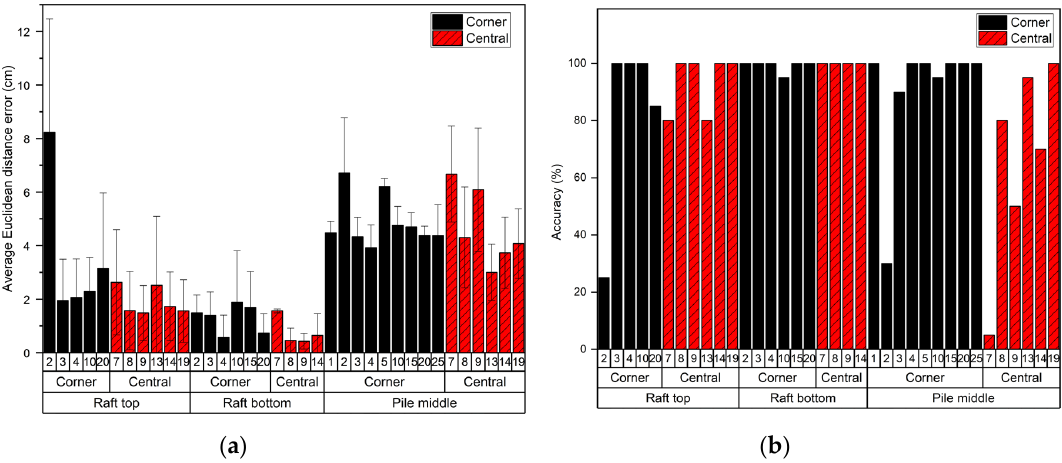
Figure 8. The accuracy of source localization estimated from the single-stage AIC method: ( a ) average Euclidean distance error, ( b ) zoning accuracy. The corner region includes Piles #1, 2, 3, 4, 5, 10, 15, 20, and 25. The centeral region includes Piles #7, 8, 9, 13, 14, and 19.